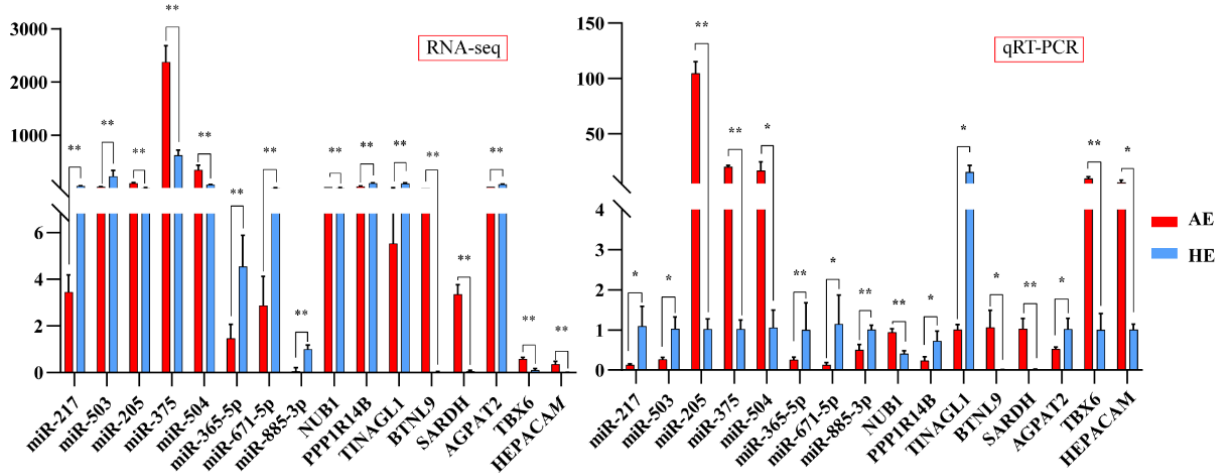
Figure 6. Validation of the expression of miRNAs and mRNAs using quantitative real-time PCR (qRT-PCR). The left and right panels represent the data of RNA-seq and qRT-PCR, respectively. The red bar represents AE, the blue bar represents HE, mean ± the standard deviation (SD) denotes the results, * represents p -value < 0.05, ** represents p -value < 0.01.